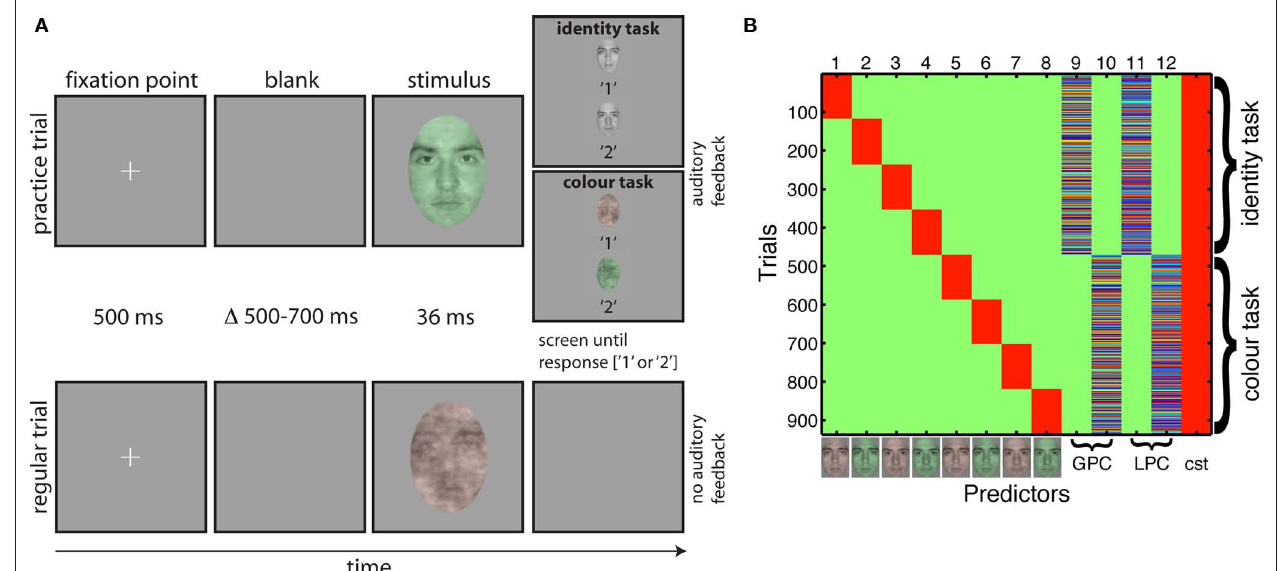
immediately after the stimulus, and remained on until the subject’s response. No feedback was provided during regular trials. Stimuli are not drawn to scale. (B) Example of a design matrix in one subject (color scale: green = 0; red = 1). The first eight predictors were categorical: they indicate the stimulus type (i.e., red or green, face 1 or 2) and the task. The next four predictors were continuous: global phase coherence (GPC) and local phase coherence (LPC) in the identity and color tasks. Each continuous predictor was z -scored independently before insertion in the design matrix. The last column was a constant term (cst